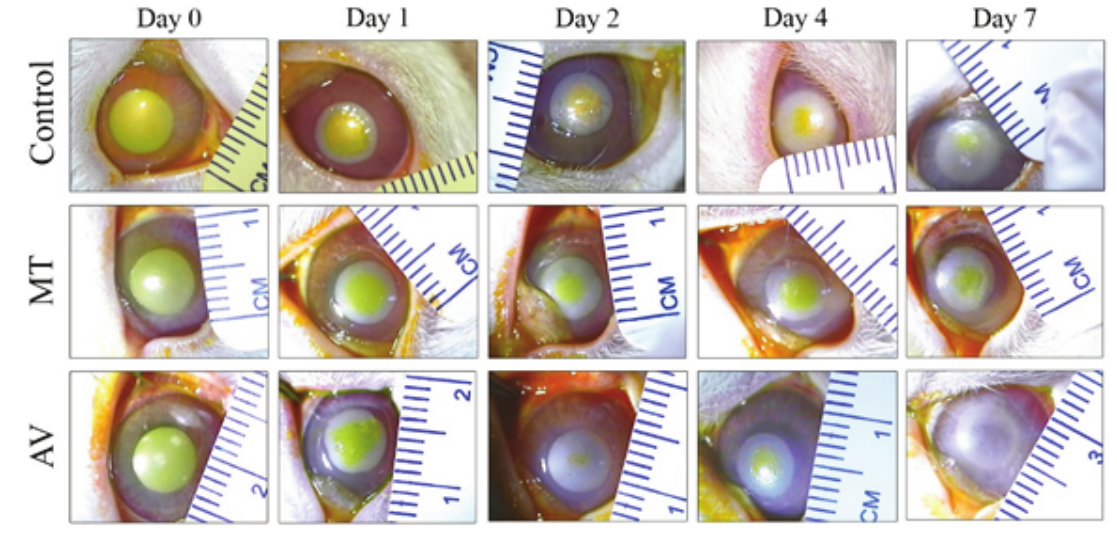
Figure 1. Mean CED areas and changes in the defective areas in the AV, MT, and control groups over the seven-day period are illustrated in the representative graph, showing a greater rate of corneal re-epithelialization in the AV group than that in the other two groups. AV, Aloe Vera; CED, corneal epithelial defect; MT, medical therapy.